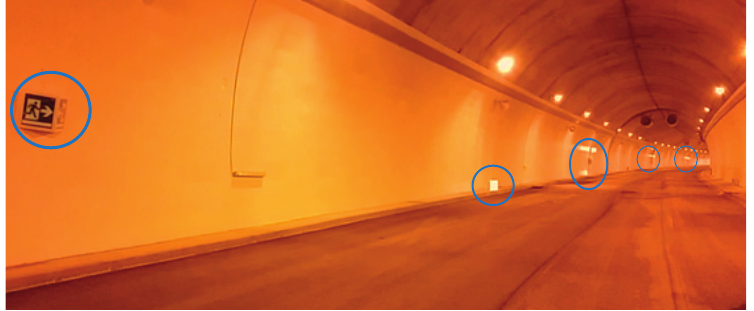
Figure 13. Snapshot during setup process. The closest signal (hanging on the wall) is turned off and the rest are turned